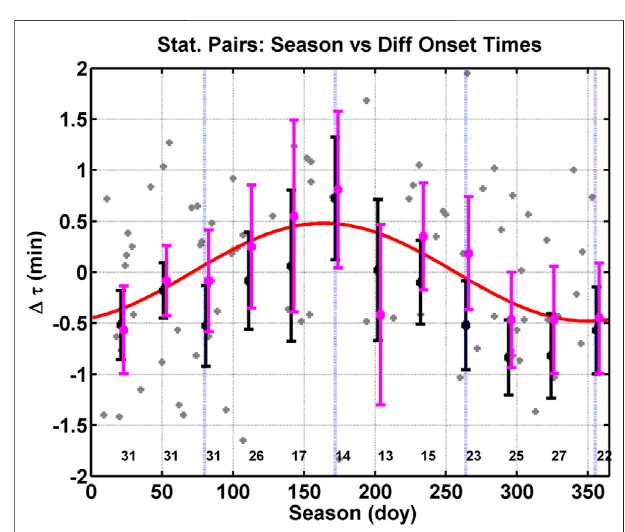
FIGURE 13 | Format of this fi gure is the same as Figure 8 . In this fi gure, we have used the southern and northern hemisphere onsets identi fi ed by eye to determine the difference in onset